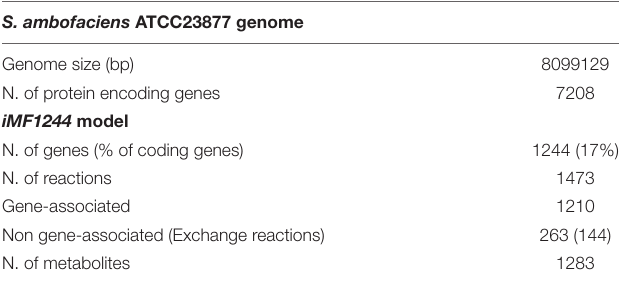
TABLE 1 | Main features of the Streptomyces ambofaciens ATCC23877 metabolic